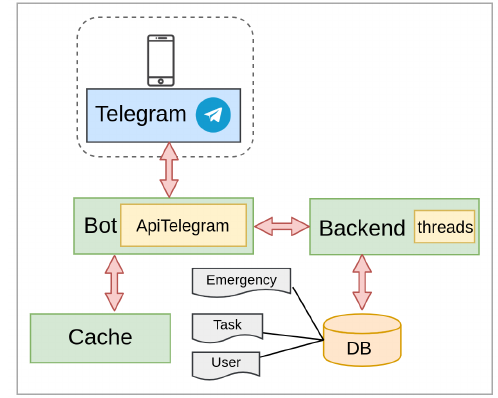
Figure 8. General scheme of the Ayni application.